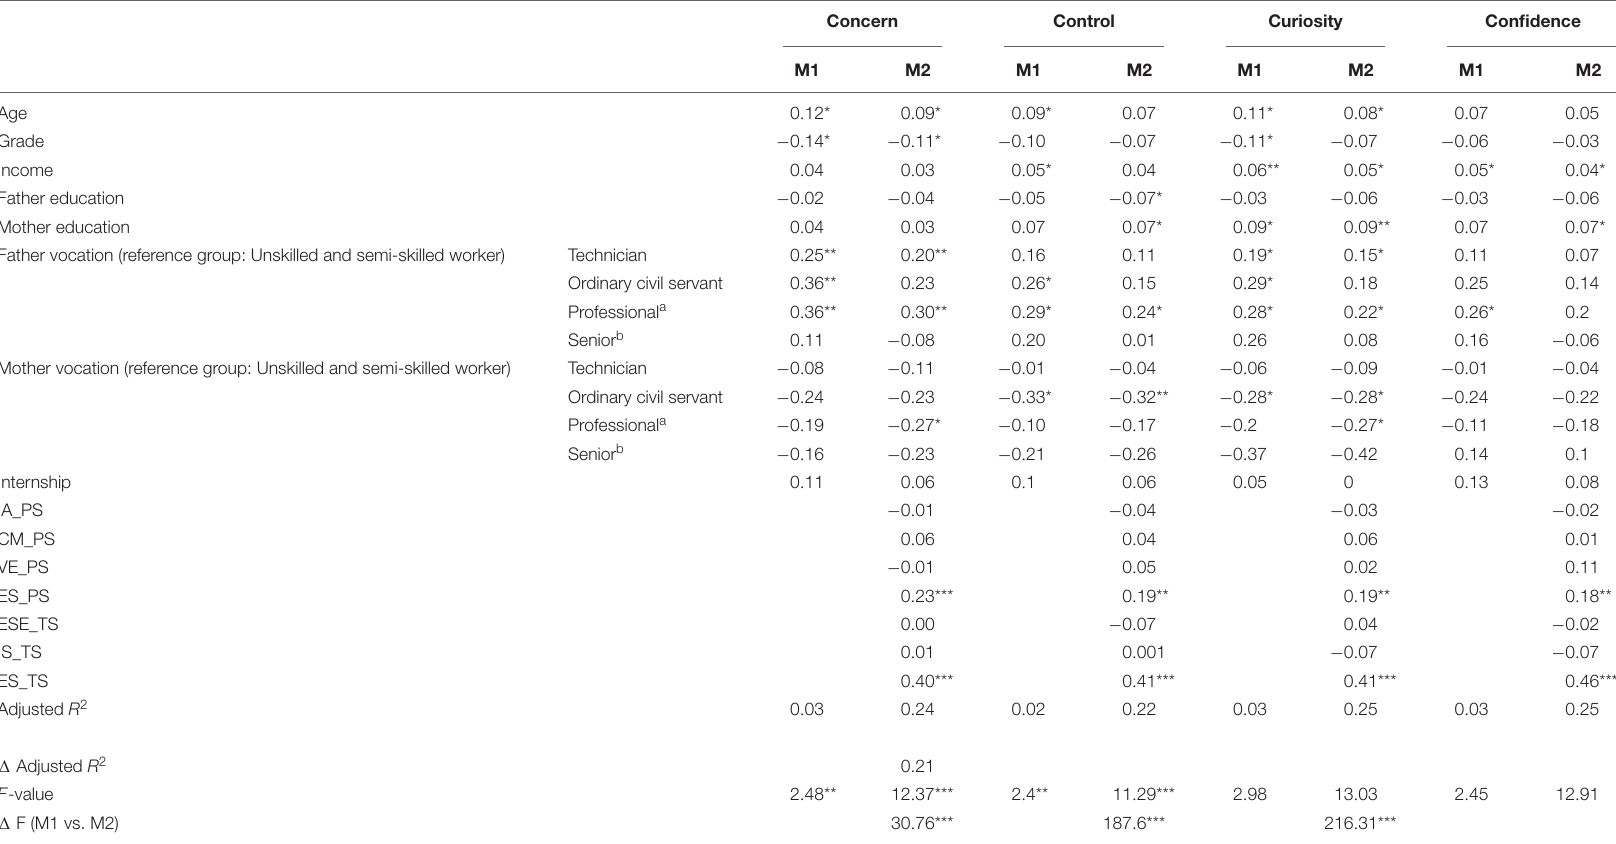
TABLE 3 | Results of hierarchical regression analysis for career concern, control, curiosity, and confidence ( n = 765).